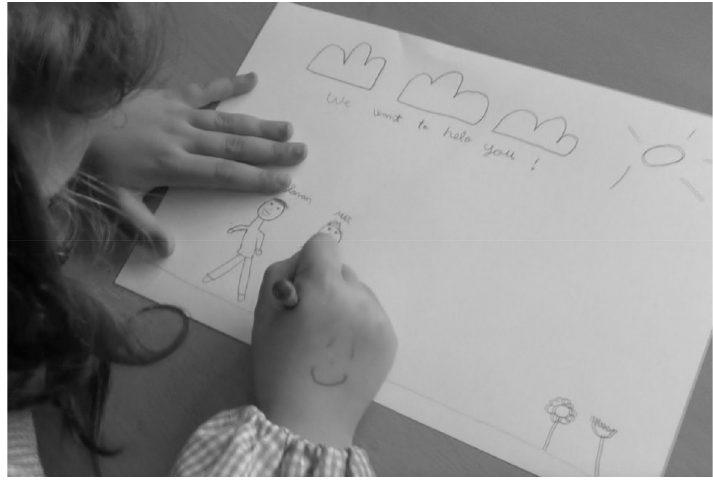
Figure 2. Page from the birthday